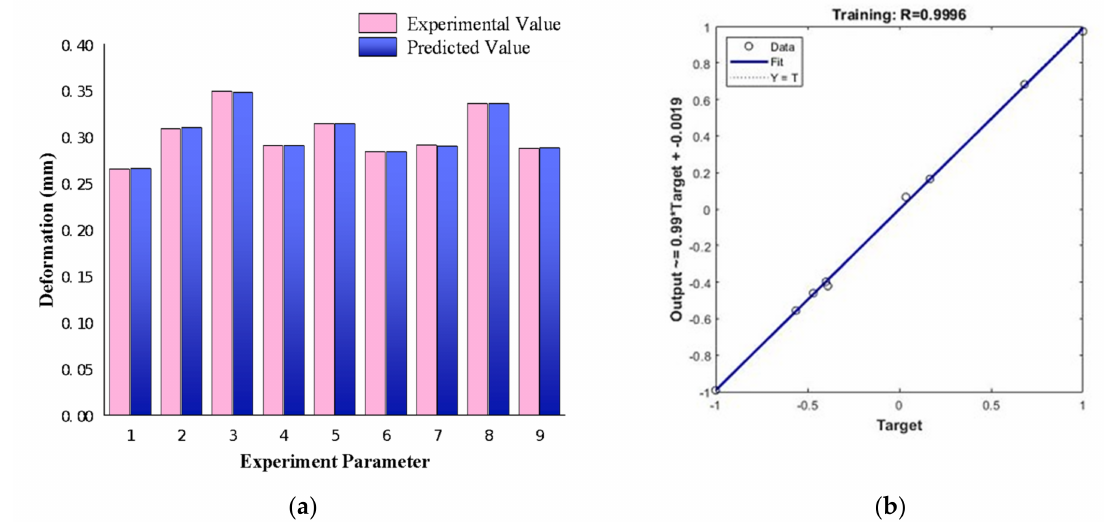
Figure 4. ( a ) Comparison of experimental data with predicted values; ( b ) Experimental values and curve fitting of predicted values.